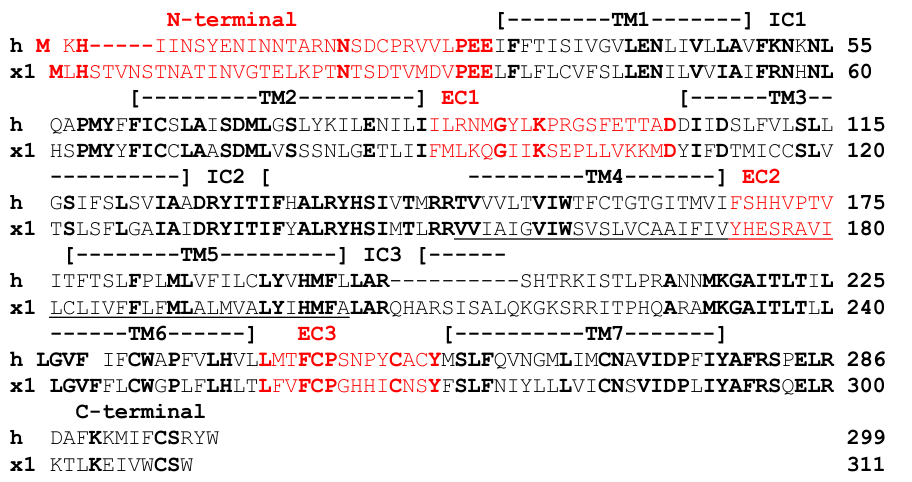
Figure 1. Alignment of Amino Acid Sequences of hMC2R and xtMC1R. The hypothetical membrane topology of hMC2R was predicted using the TMHMM program (https://www.bioinformatics.dtu.dk, accessed on 18 October 2018). The amino acid sequence of xtMC1R was aligned to hMC2R by inserting two gaps. The predicted extracellular domains of hMC2R and xtMC1R are highlighted in red. Identical positions in both receptors are in bold red for residues in an extracellular domain and bold black for residues in a TM, IC, or C-terminal domain. Abbreviations: h (human), x ( Xenopus tropicalis ), EC (extracellular domain, IC (intracellular domain), TM (transmembrane domain).